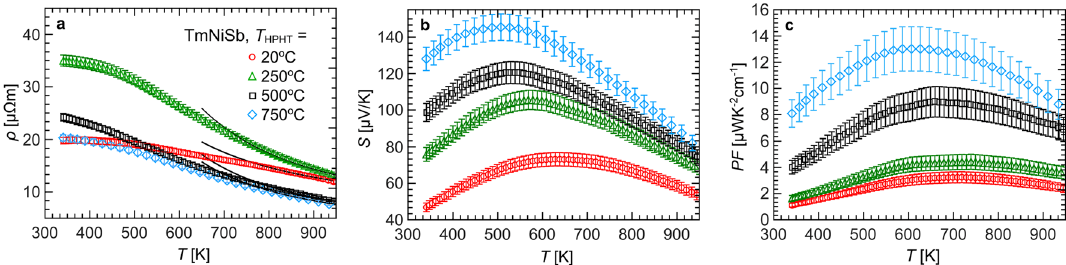
Figure 7. Temperature variations of ( a ) electrical resistivity, ( b ) Seebeck coefficient, and ( c ) power factor for TmNiSb samples sintered at different